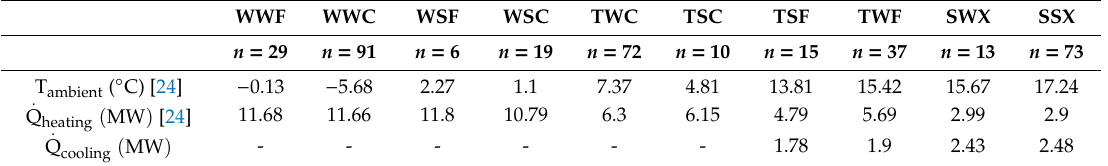
Table 4. Corresponding mean values of heating, cooling and ambient temperature for di ff erent typical days